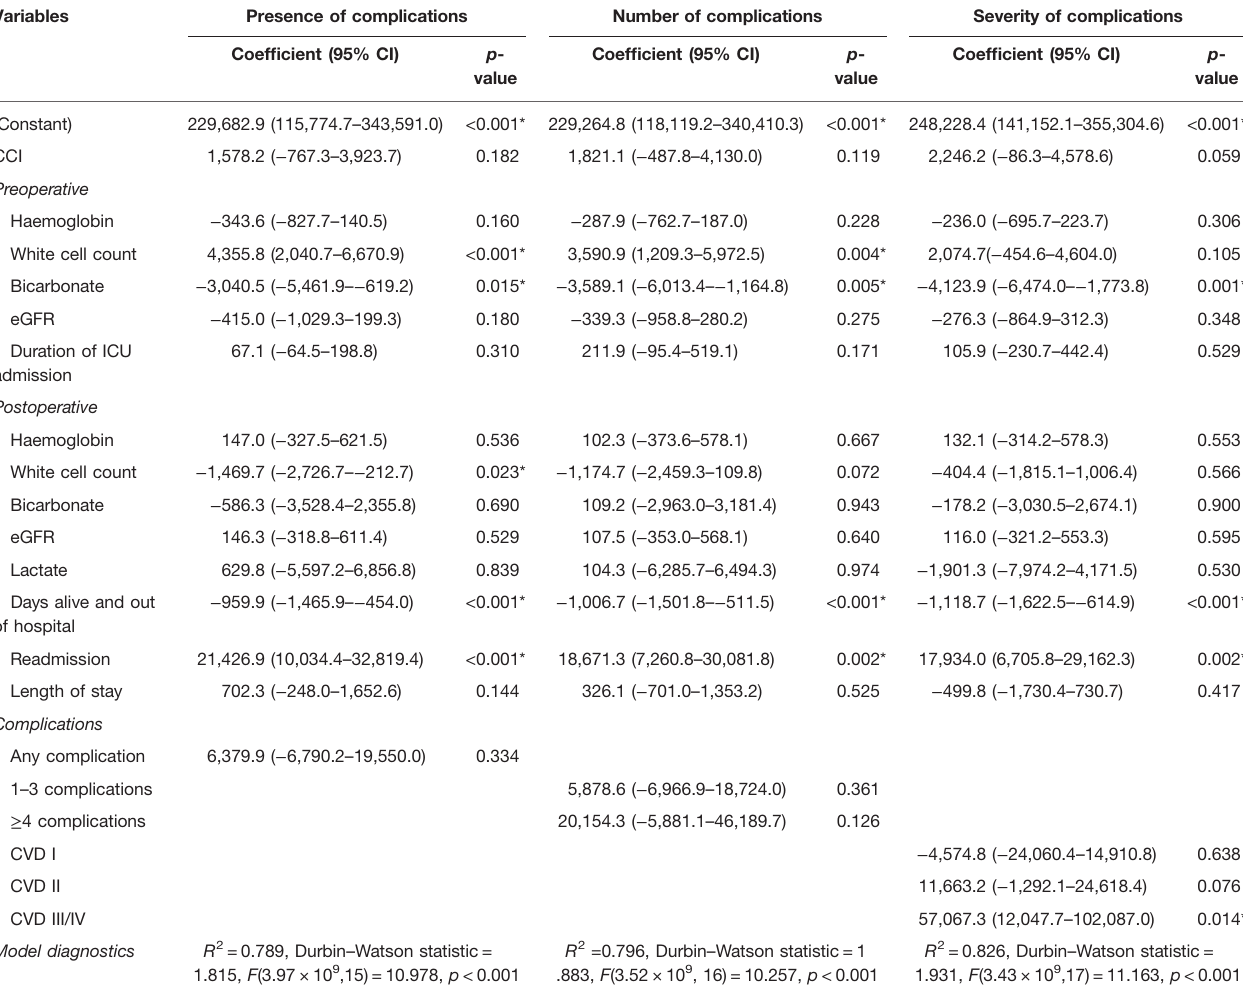
TABLE 4 | Adjusted hospital cost regression